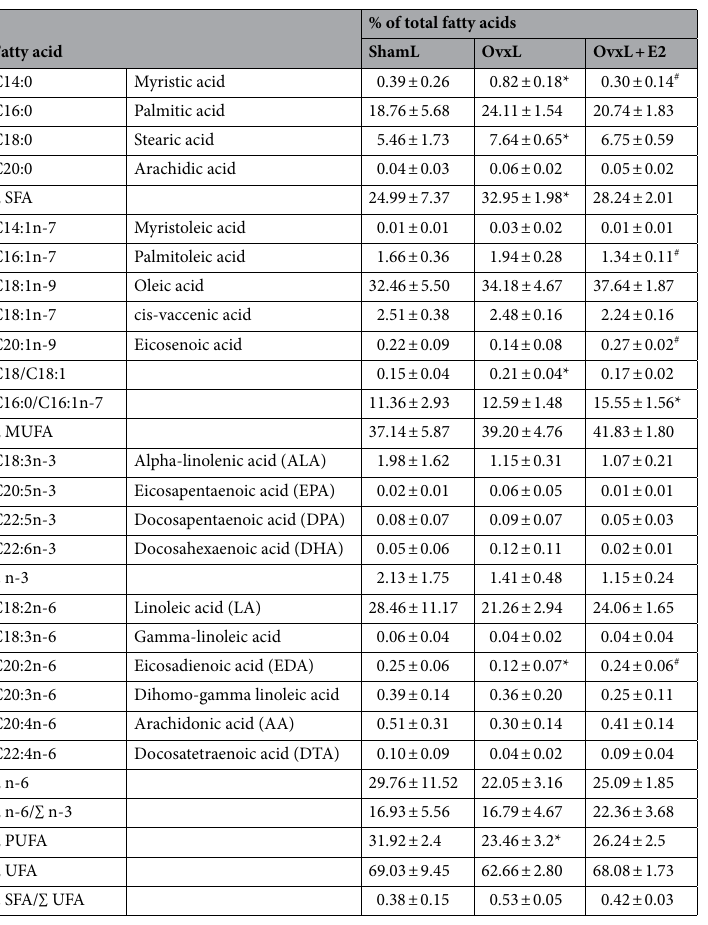
Table 5. Fatty acid profile of RET monoglyceride diglyceride lipids obtained from ovariectomized (Ovx) or Sham operated rats, fed a lard-enriched (L) diet, subjected or not to oestrogen replacement therapy (E2). Data presented as means ± standard error (SE) of the % of FAs. n = 6 for each group. SFA saturated fatty acids, MUFA monounsaturated fatty acids, PUFA polyunsaturated fatty acids. *p < 0.05 vs ShamL; #p < 0.05 OvxL vs OvxL +